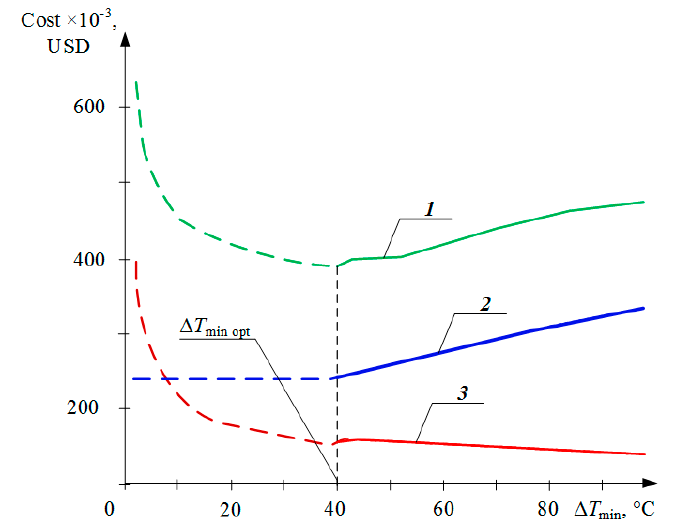
Figure 5. Dependence of the discounted values on the minimum value of the driving force of heat exchange in the heat energy recovery system of the EB production process. 1—the total present value of the project; 2—the annual cost of the used useful energy; 3—the reduced value of capital investments; dashed lines are not existing values.